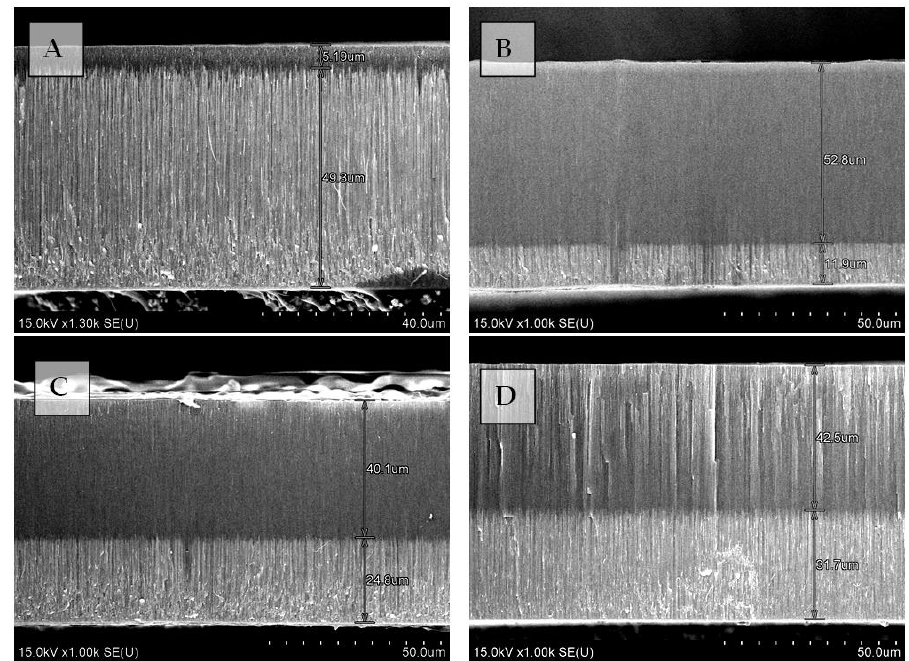
Figure 3. SEM images of the Ni NWs in MPAA pores of different thicknesses: ( A )—55 μm, sample type II, No. 6; ( B )—65 μm, sample type I, No. 1; ( C )—65 μm, sample type I, No. 3; ( D )—75 µm, sample type II, no. 4.